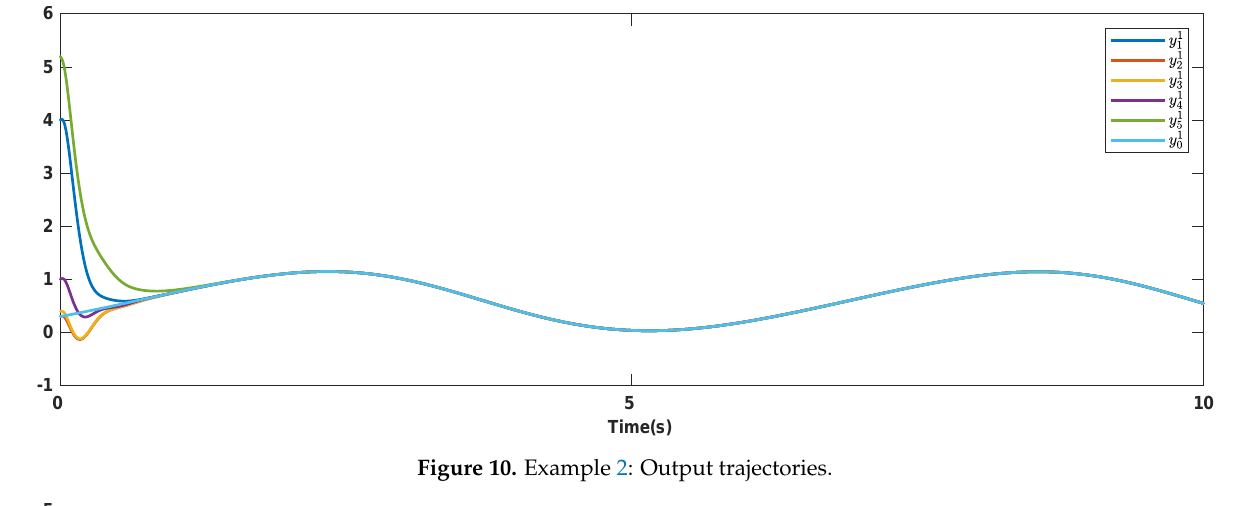
Figure 10. Example 2: Output trajectories.